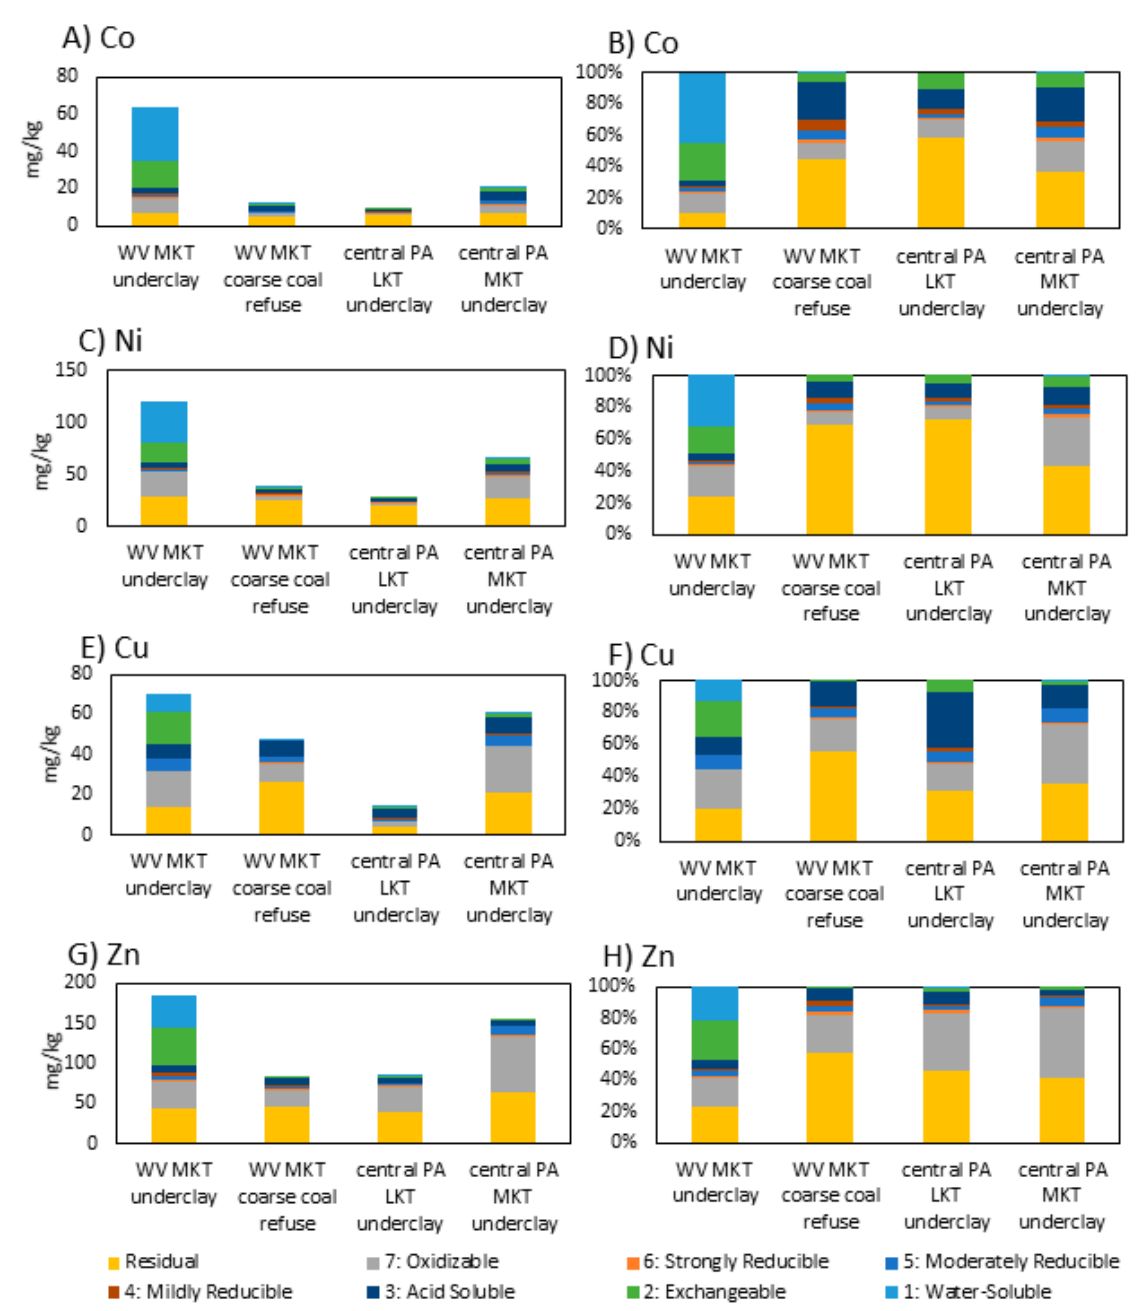
Figure 4. ( A ) Distribution of Co from sequential extractions. ( B ) Plot of Co distribution from sequential extractions normalized to percentage extraction. ( C ) Distribution of Ni from sequential extractions. ( D ) Plot of Ni distribution from sequential extractions normalized to percentage extraction. ( E ) Distribution of Cu from sequential extractions. ( F ) Plot of Cu distribution from sequential extractions normalized to percentage extraction. ( G ) Distribution of Zn from sequential extractions. ( H ) Plot of Co distribution from sequential extractions normalized to percentage extraction.